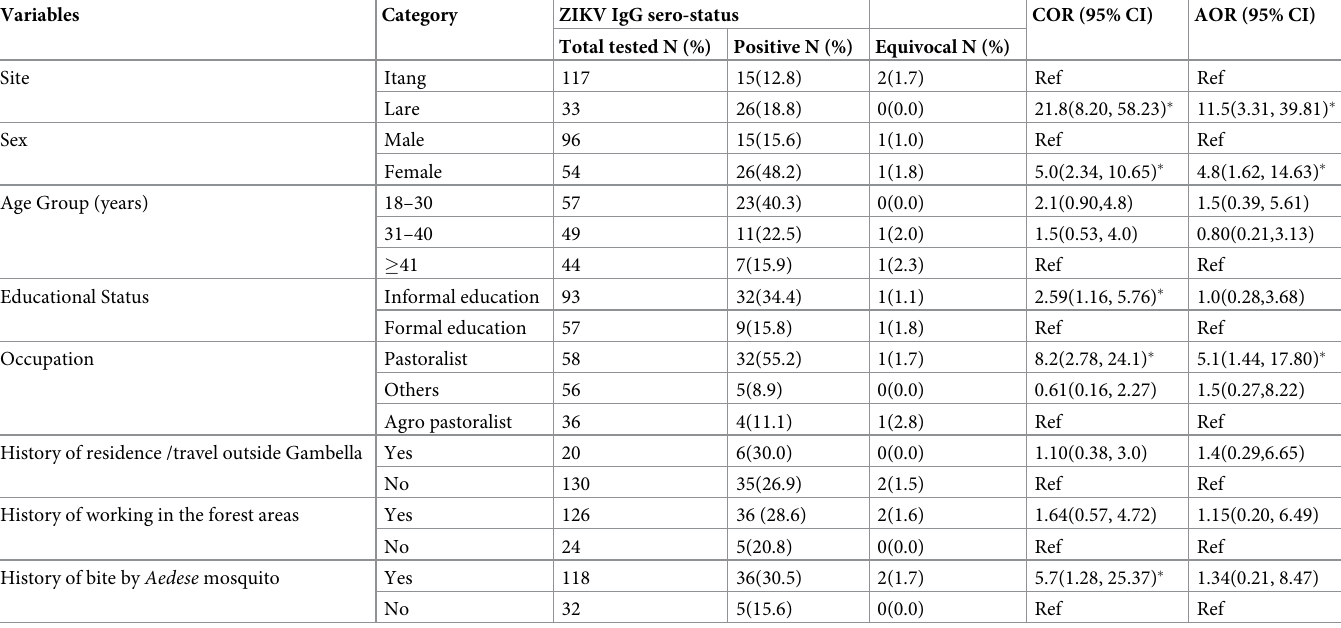
Table 4. Seropositivity for IgG antibody to ZIKV and associated factors in the study participants (N = 150).